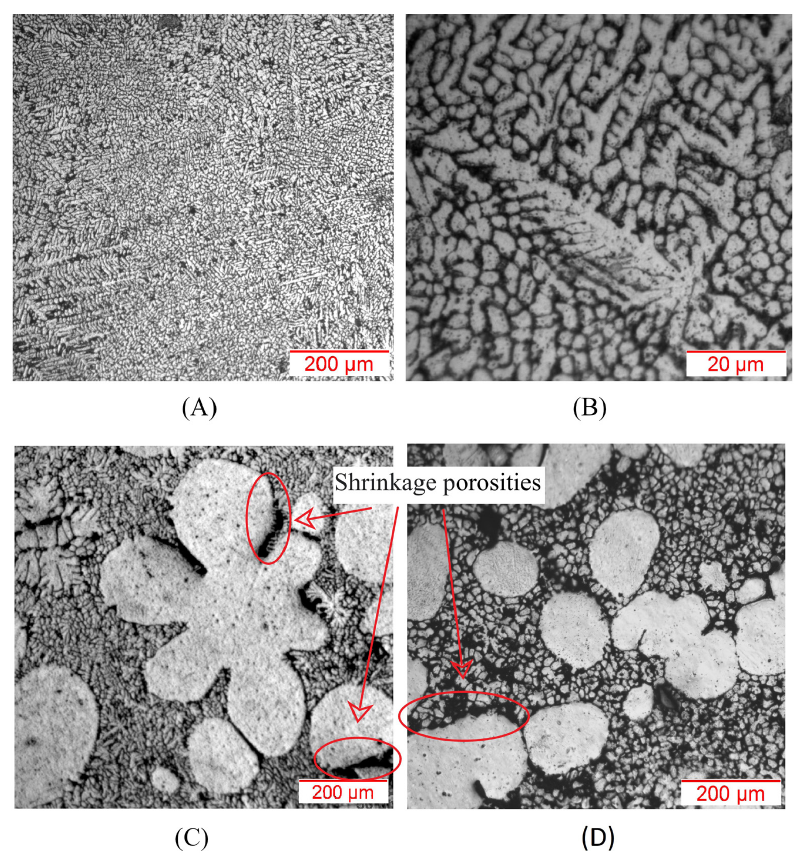
Figure 4. Microstructure of the 6 mm samples: (A) and (B) Unprocessed sample with zero percent solid fraction in different magnifications (CS sample); (C) Non-stirred sample with 25% percent solid fraction (0-minute sample); (D) Processed sample (1-minute sample).